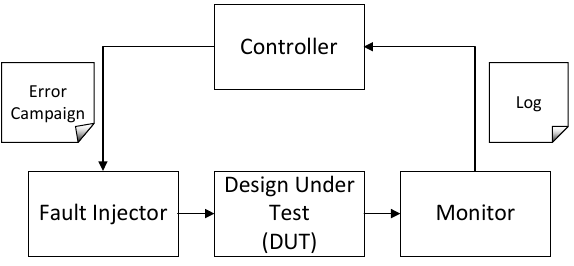
Figure 4. Basic components of an error injection environment.